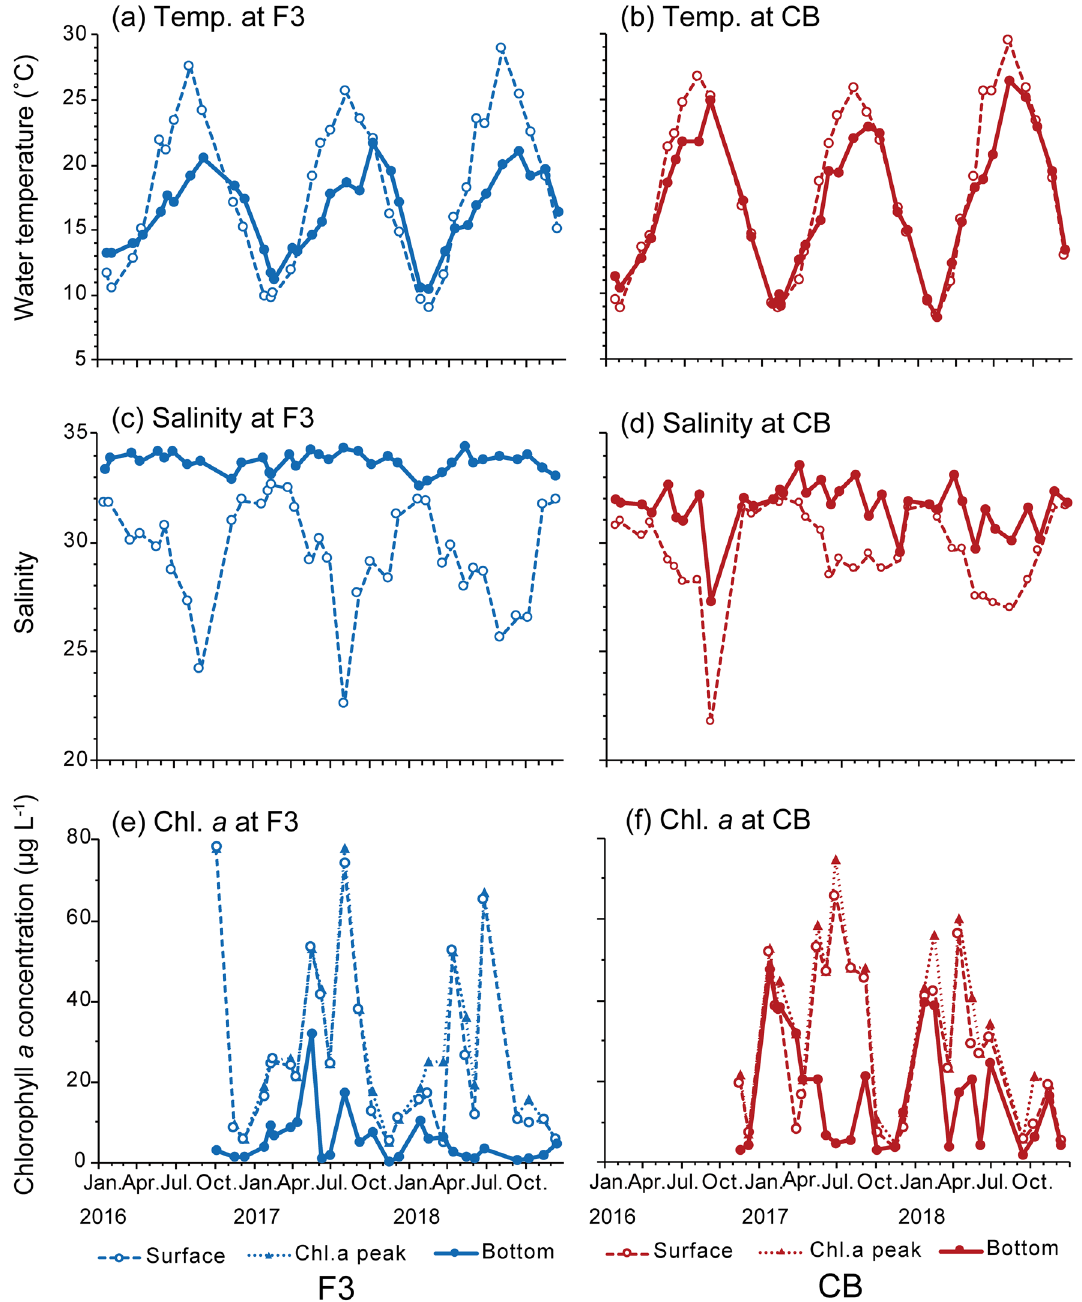
Figure 2. Seasonal changes in water temperature ( a ), salinity ( b ) and chlorophyll a concentration (Chl.) at St. F3 ( c ), St. CB ( d ). ( a ), ( b ): from January 21, 2016 through June 26, 2018. ( c ), ( d ): from October 5, 2016